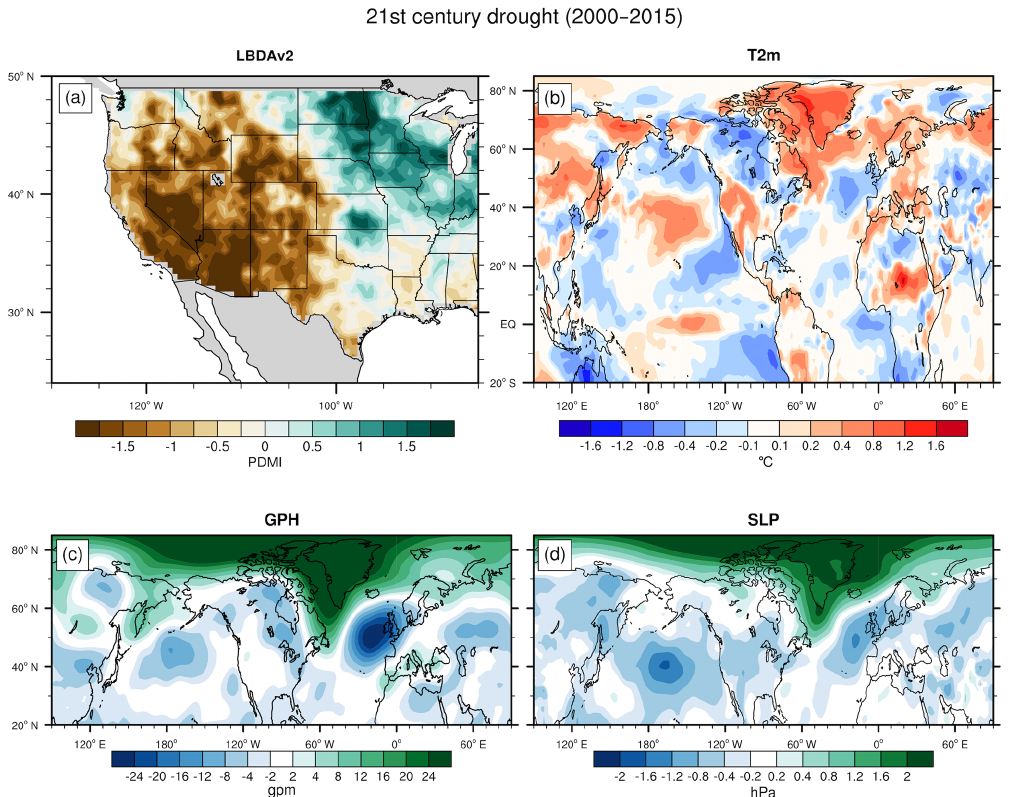
Figure 5. The 21st century drought (2000–2015) in the PMDI of the LBDAv2 (a) , composites relative to the preceding 5-year period and the following 3-year period (only 2016–2018 available) of 2m temperature (T2m) (b) , 500hPa geopotential height (GPH) (c) , and sea-level pressure (SLP) (d) from the ERA-Interim